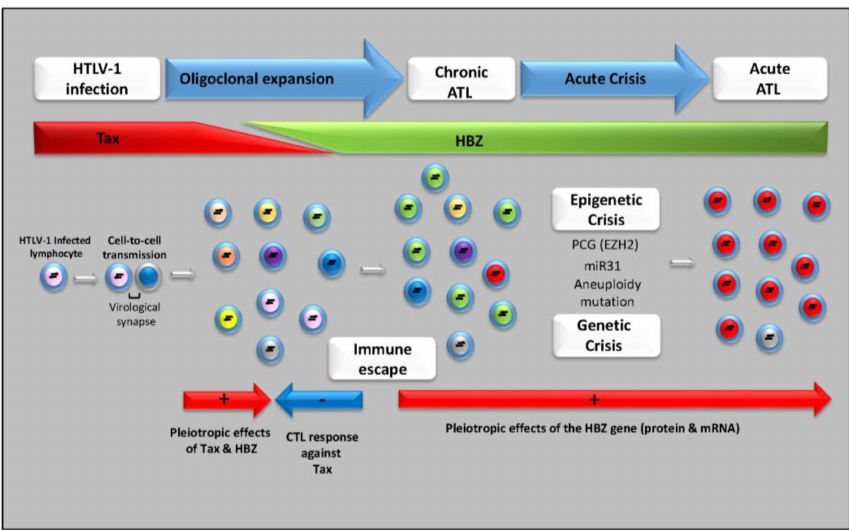
Figure 2. Model for ATL development. HTLV-1 is transmitted in a cell-to-cell fashion via a virological synapse. After infection, HTLV-1 promotes clonal proliferation of infected cells by pleiotropic actions of Tax and other viral proteins. Tax is considered crucial for the oligoclonal maintenance and expansion of HTLV-1-infected cells during the early phase but is only transiently expressed by HTLV-1-infected cells. Proliferation of HTLV-1-infected cells is controlled by cytotoxic T-cells in vivo . Thereafter, continuing expression of HBZ is followed by genetic/epigenetic loss of function of tumor suppressor genes and modulation of micro RNA levels. After a long latent period, ATL develops in about 5% of asymptomatic carriers. Diverse genetic abnormalities are acquired during the progression to ATL from an indolent to an aggressive disease